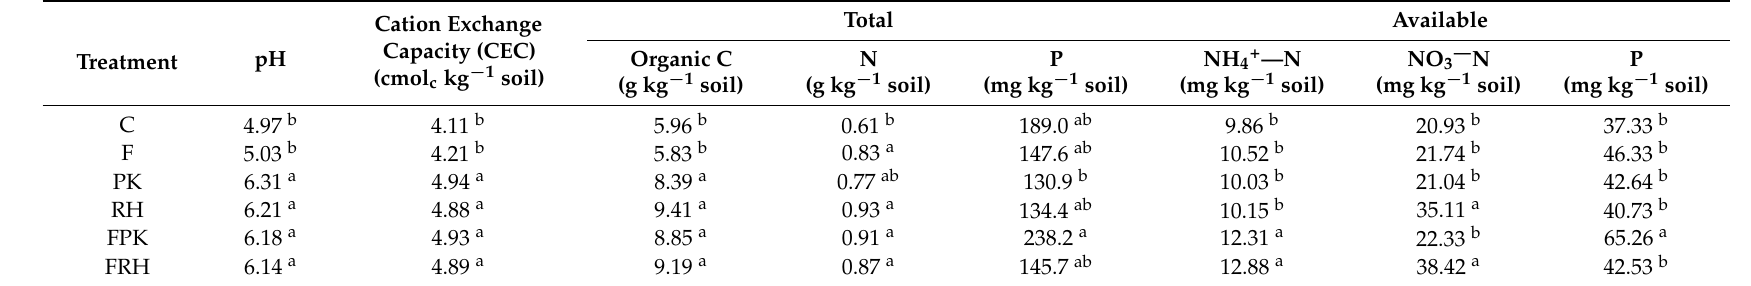
Table 2. Soil properties after the 75 day of planting.